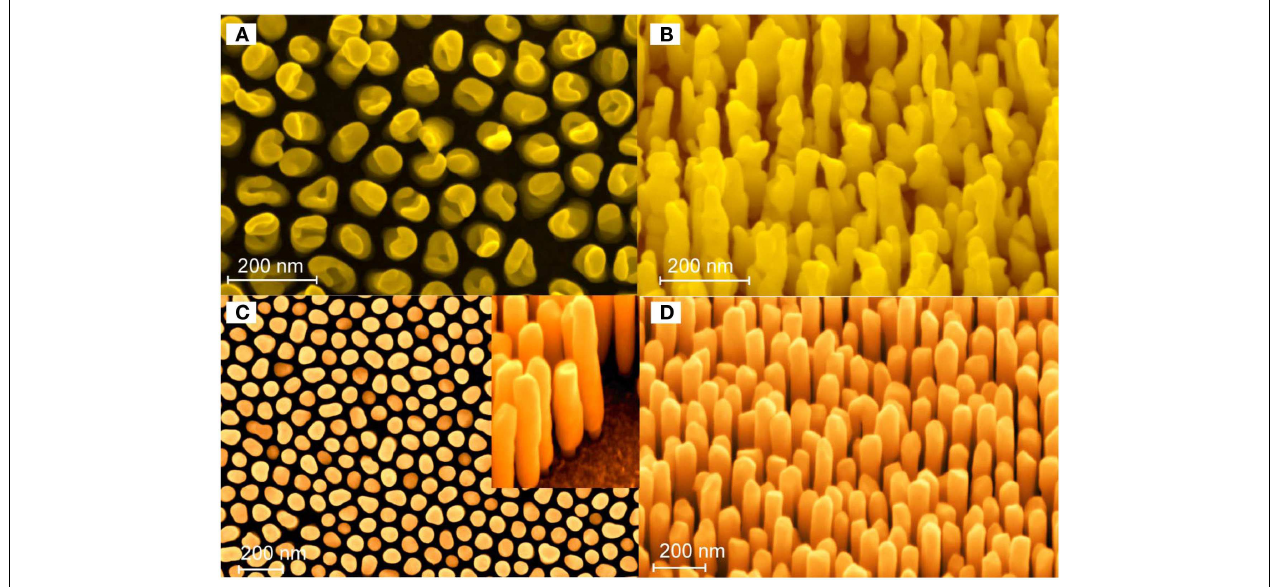
FIGURE 5 | SEM secondary electron micrographs showing different Au-NR morphologies; (A,B) top and side views, respectively, ofAu-NRs processed potentiostatically using an HAuClO4 electrolyte; (C,D)Au-NRs